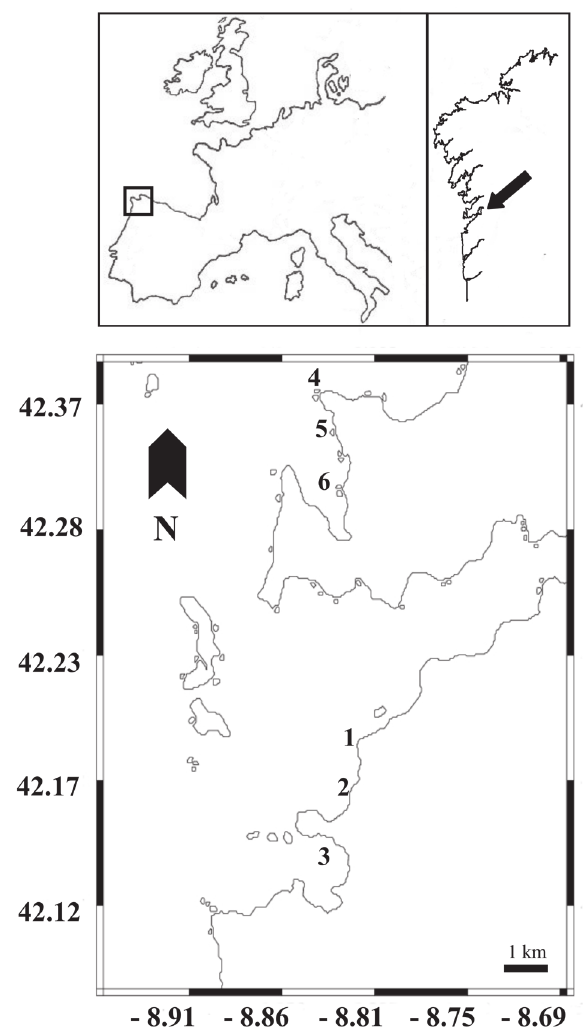
Fig . 1. – the study area and position of the locations within the two rias. location 1: Canido; location 2: Cabo estai; location 3: Monte lourido; location 4: Cabo udra; location 5: areas de bon; location 6: